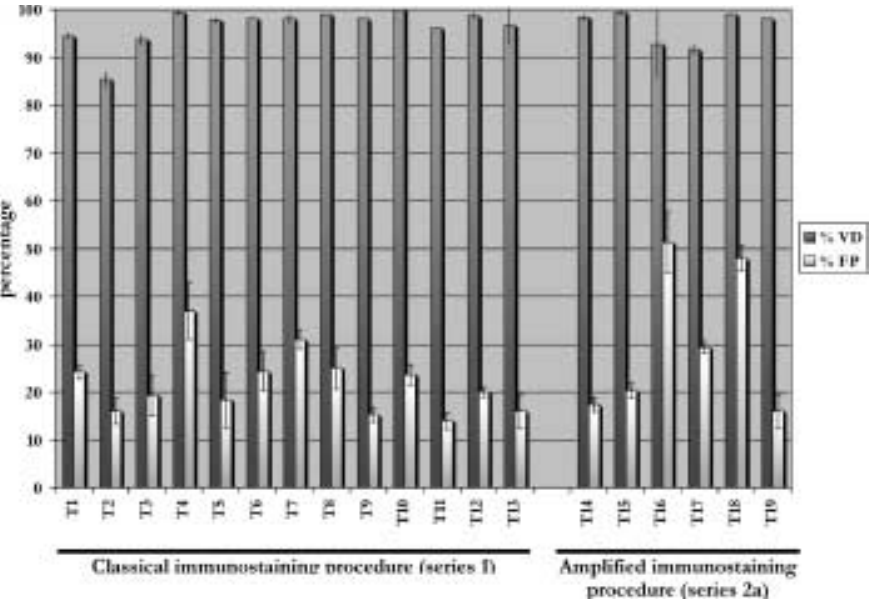
Fig. 6. Comparison of results obtained after classical and enhanced immunostaining procedure. Well detected vessel (%VD) and false-positive (%FP) rates were determined for each labelling method used. DAB was used as chromogen for both